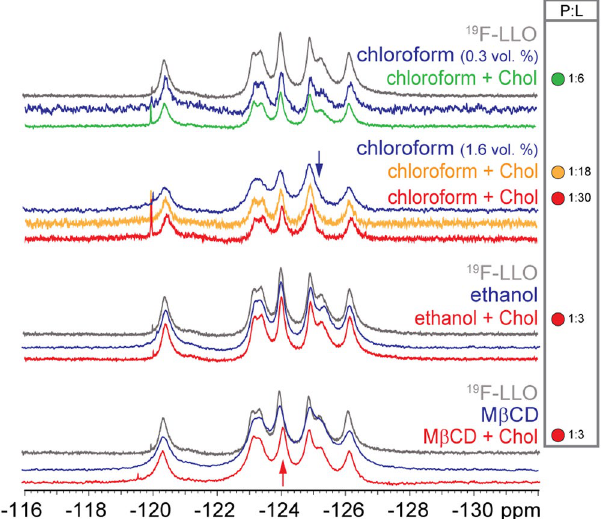
Figure 5. Interaction of LLO with Chol in solution as monitored by 19 F NMR. 19 F NMR spectra of 0.3 mM 19 F-LLO treated with Chol dissolved in chloroform (1:6, 1:18 and 1:30 19 F-LLO:Chol molar ratios), ethanol or in a complex with M β CD (both 1:3 19 F-LLO:Chol molar ratio) compared to 19 F-LLO spectra. P:L, protein:lipid (cholesterol) molar